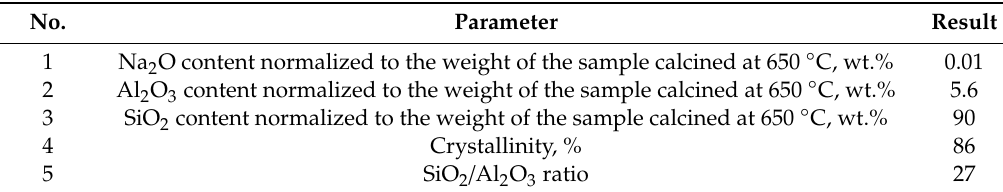
Table 3. Characteristics of the BEA zeolite.